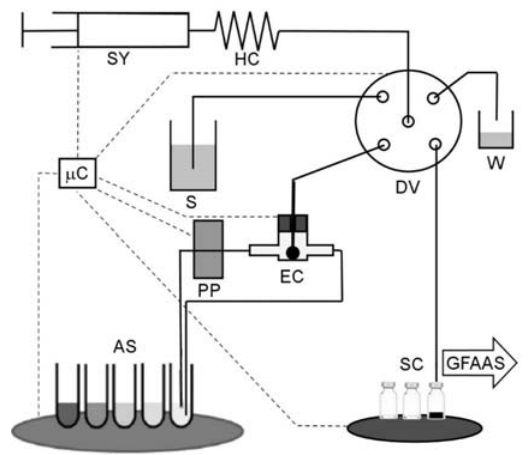
Figure 7. The proposed semi-automatic apparatus for chromium speciation method SY: syringe + steeper motor, HC: holding coil, DV: distribution valve (Hamilton), W: waste, S: organic solvent, PP: peristaltic pump, EC: extraction cell, AS: auto-sampler, SC: sample collector, μC: microcontroller